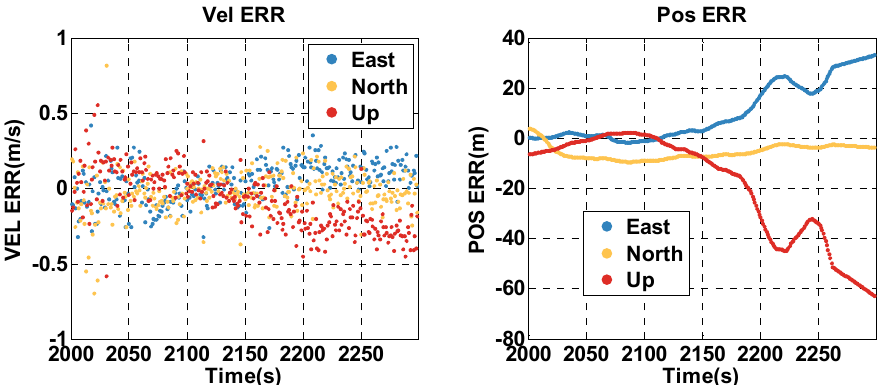
Figure 16. The position and velocity errors of the traditional GNSS/INS tightly coupled integration in the insufficient satellites context in the experimental test. Table 5. Statistical analysis of the errors of the MTF method and the traditional GNSS/INS tightly coupled integration in the insufficient satellites context in the experimental test.